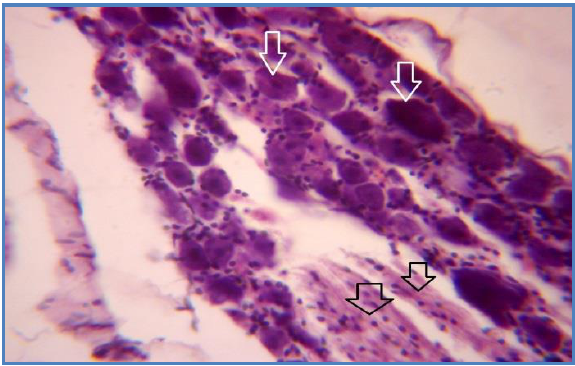
Figure, 2: Weaning group, L6. Sensory neurons small, darkly stained and oval in shape (white arrows). Bundles of nerve fibers (black arrows) 40X.H and E.